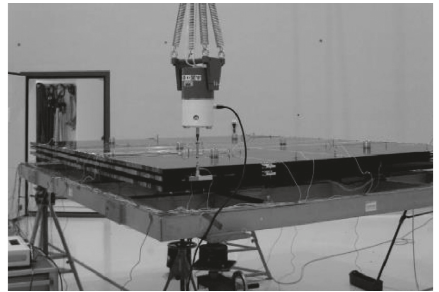
Figure 3: PIM method test input power.